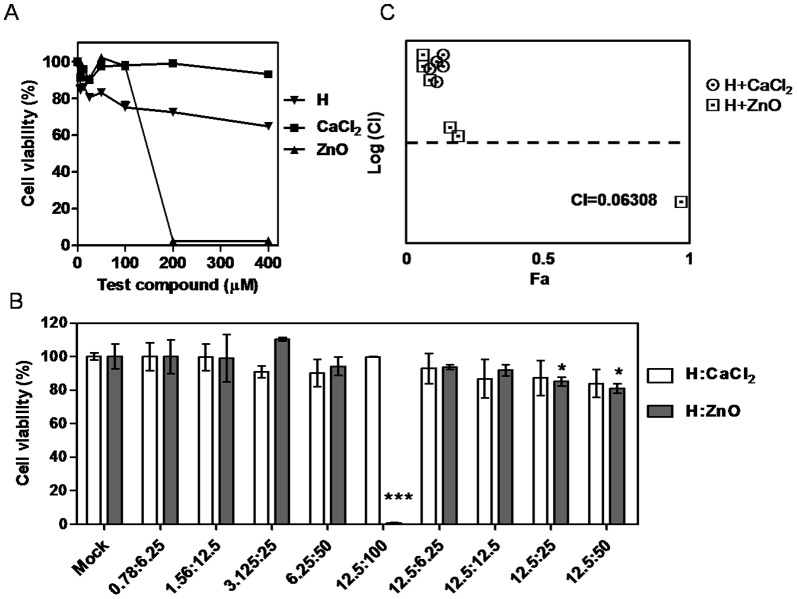
Combined hinokitiol and ZnO treatment created strong synergism.(A) MTT test analysis of the cytotoxicity of hinokitiol (H), CaCl2, and ZnO treated to MG-63 for 24 h. Vehicle (0.1% DMSO) and test compounds (6.25 µM-400 µM) were tested. Three independent experiments were performed in triplicate. (B) MTT test analysis of the cytotoxicity of combined various dosages of H:CaCl2, and H:ZnO to MG-63. Column, mean of more than triplicate analysis; bars, SE. (C) Logarithmic combination index plot for combo of H+CaCl2, and H+ZnO. Unpaired t test. *, P<0.05; ***, P<0.001.